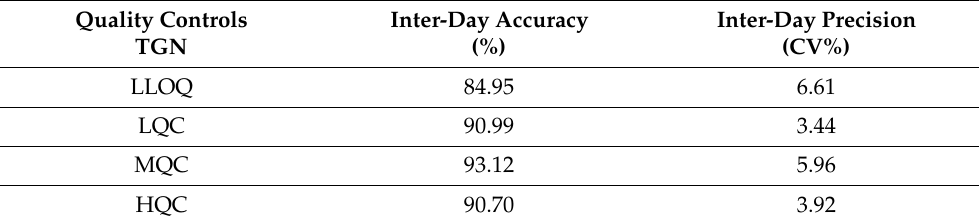
Table 8. Inter-day accuracy and precision (CV%) referred to QCs of